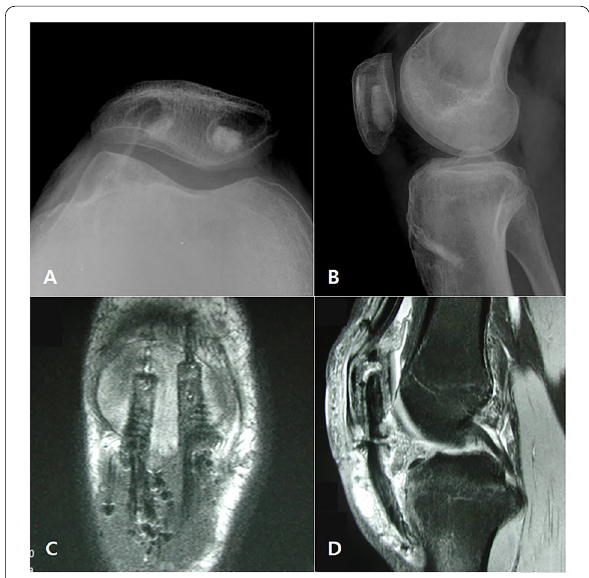
Fig. 4. Postoperative images. a Skyline view of plain radiograph ( b ) Lateral view of plain radiograph. c T2 weighted sagittal MRI. d T1 weighted coronal MRI